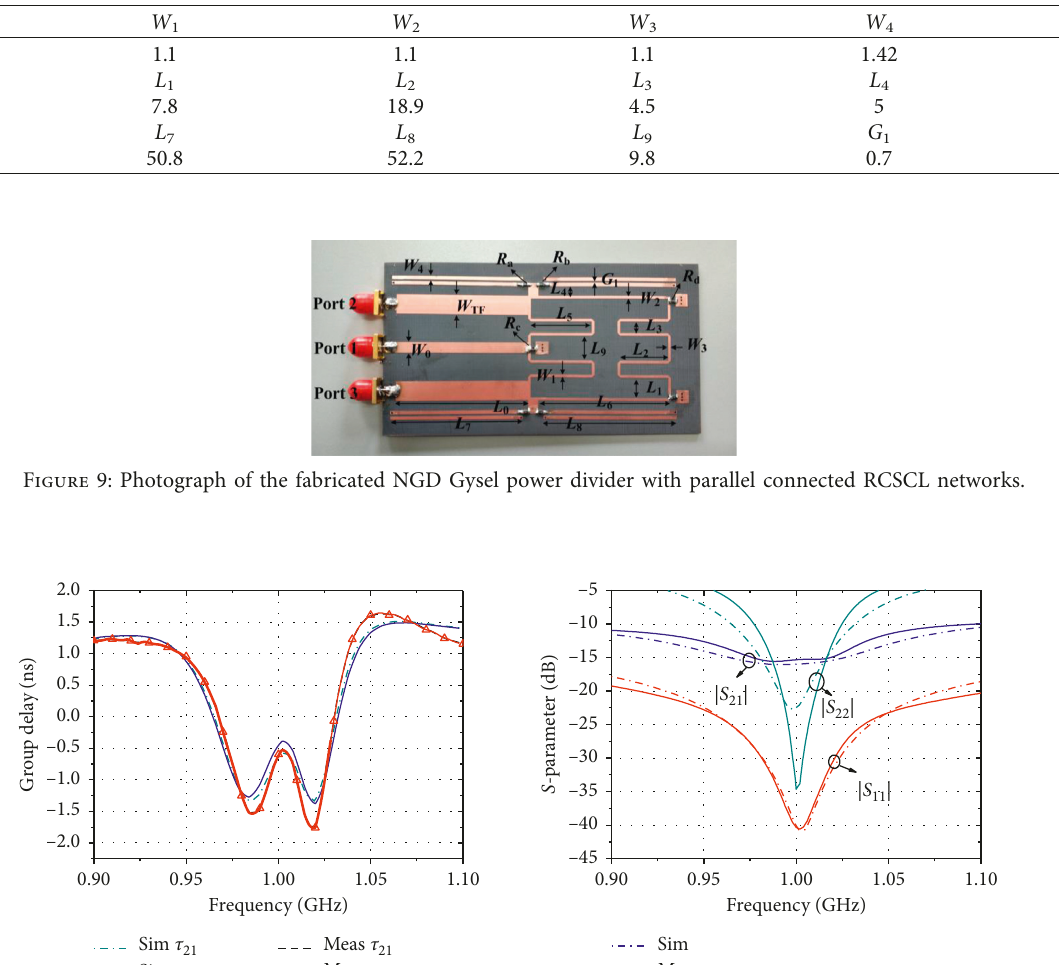
Figure 8: Configuration of the proposed power divider with parallel connected RCSCL networks. Table 3: Dimensions of power divider with two-stage RCSCL networks (unit: mm; refer to Figure 9).